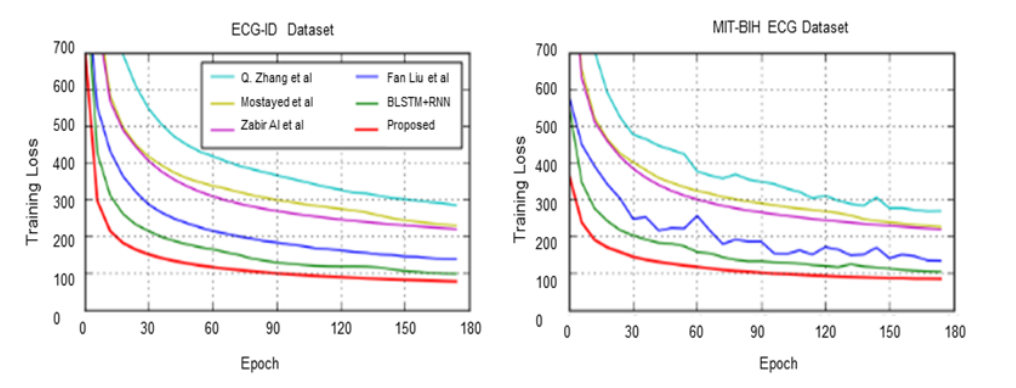
Figure 10. Comparison of cross-entropy loss per epoch over ECG-ID dataset and MIT-BIH ECG dataset.